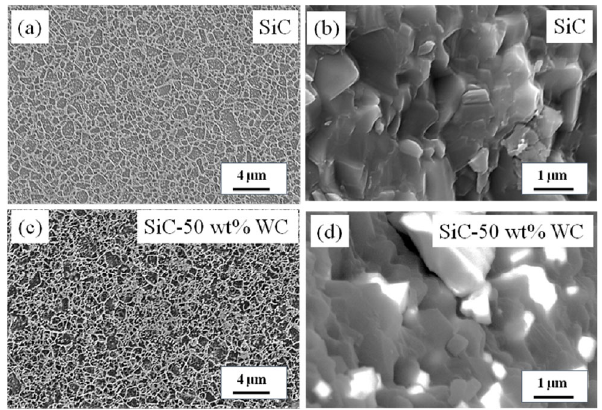
Fig. 1 SEM images of etched and fractured surface of SiC ceramics ((a) and (b)), and SiC ceramics reinforced with 50 wt% of WC ((c) and